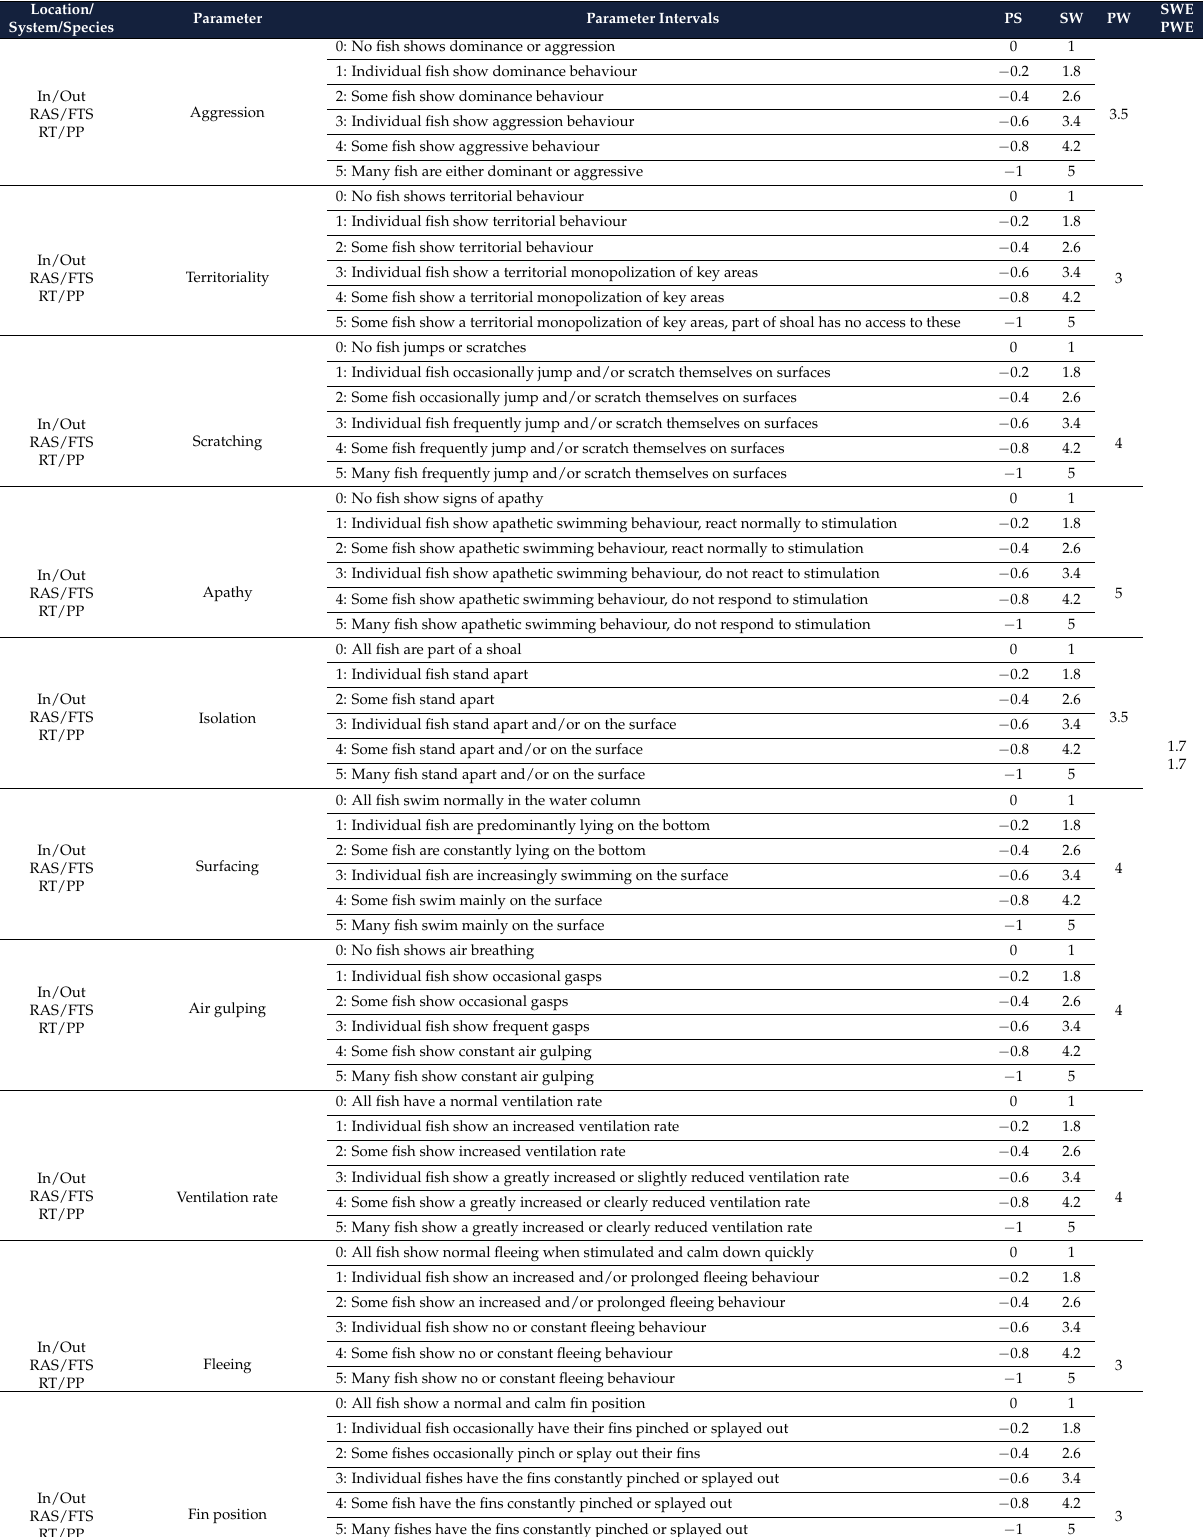
Table A3. Module fish group behaviour (1/2). In = indoor, Out = outdoor, RAS = recirculating aquaculture system, FTS = flow-through system, RT = rainbow trout, PP = pikeperch, PS = parameter score, SW = score weight, PW = parameter weight, SWE = score weight exponent, PWE = parameter weight